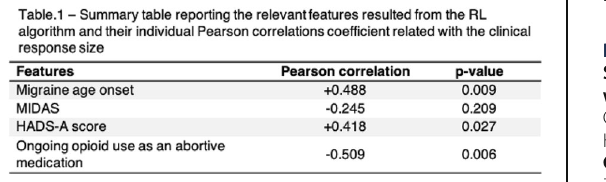
Fig. 1 (abstract P0332). See text for description